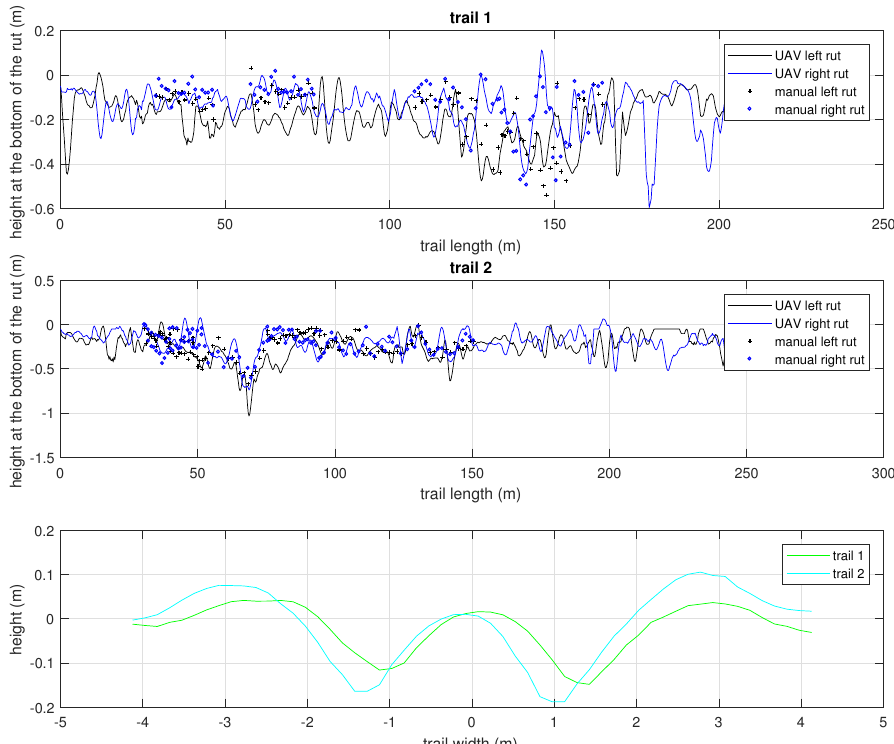
Figure 11. Top and middle : The depth profiles of the left and right rut of both trails extracted from the UAV photogrammetric point cloud. Bottom : The 3D trail cross-profile averaged over the length. The left and right ruts of each trail are visible. The reference height is set to z = 0 m. The narrow bottom of the ruts is an artificial result of the final rut profile